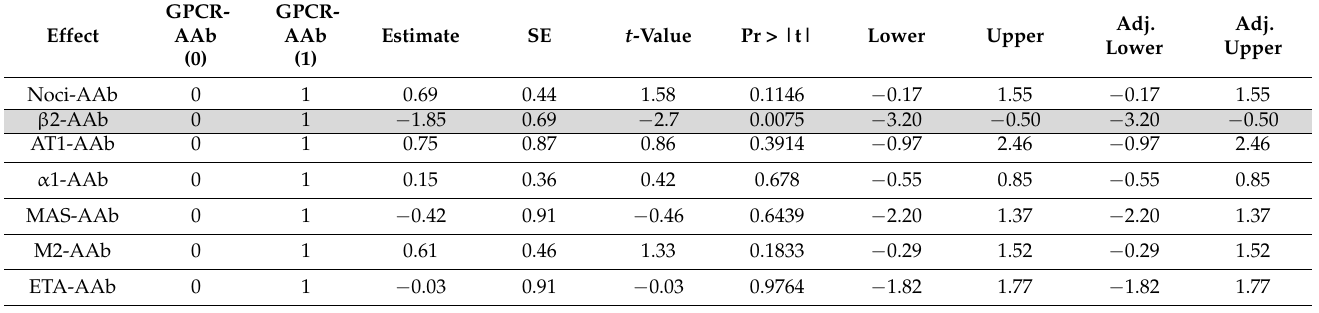
Table 3. Differences in the least square means of VDs in the SVP, ICP and DCP in patients with post-COVID-19 syndrome (PCS), considering seropositivity for GPCR-AAb (1) and seronegativity for GPCR-AAb (0). Notable significant effects were observed in the SVP for β 2-AAb ( p = 0.0075) and in the ICP for Noci-AAb ( p = 0.0344), β 2-AAb ( p = 0.0112) and ETA-AAb ( p = 0.0261), and in the DCP an associative trend with Noci-AAb ( p = 0.055) was also